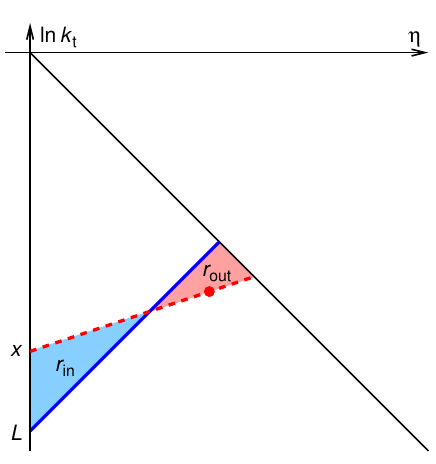
Figure 15. Primary Lund plane representation of the configuration represented in eq. (B.1), with the solid line corresponding to a fixed limit e −| L | for the observable value and the dashed-line to a fixed value of the shower ordering variable. The emission indicated with a red dot has no direct impact on Σ( α ) , but for PanScales showers with the CFFE scheme, it changes the colour factor s , L (from C to C 2 ) for all subsequent primary emissions at smaller (positive) rapidities and lower F A / values of the shower ordering variable. This effectively modifies the Sudakov for Σ( α region shaded in blue.